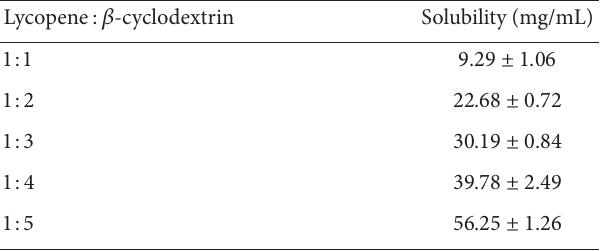
Table 2: Solubility study of solid dispersions of lycopene. Lycopene : 𝛽